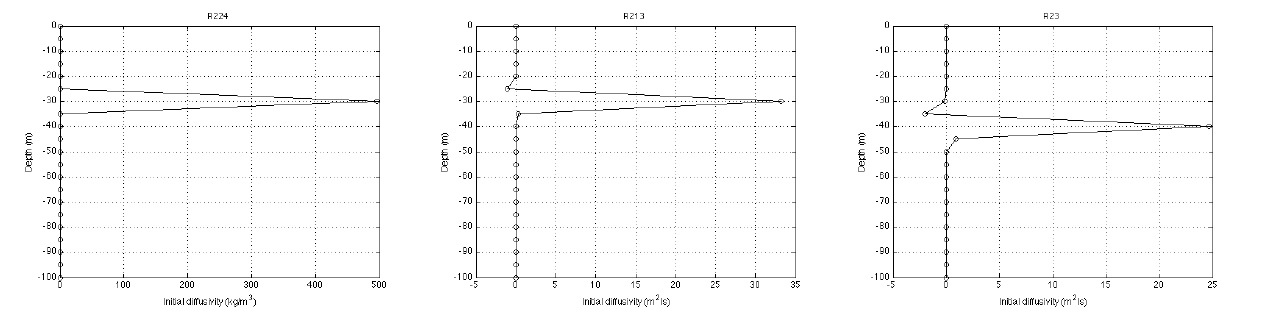
Fig. 9. Test 2: initial diffusivity for models R 224, R 213 and R 23 (from left to right).